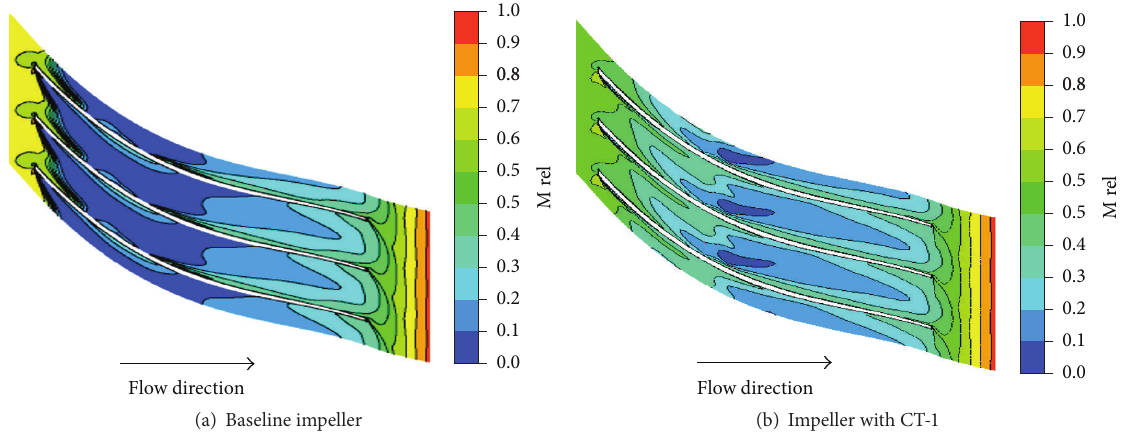
Figure 22: Relative Mach number distribution on spanwise planes of baseline and CT-1 impellers at 90% span from hub at stall mass flow rate of baseline